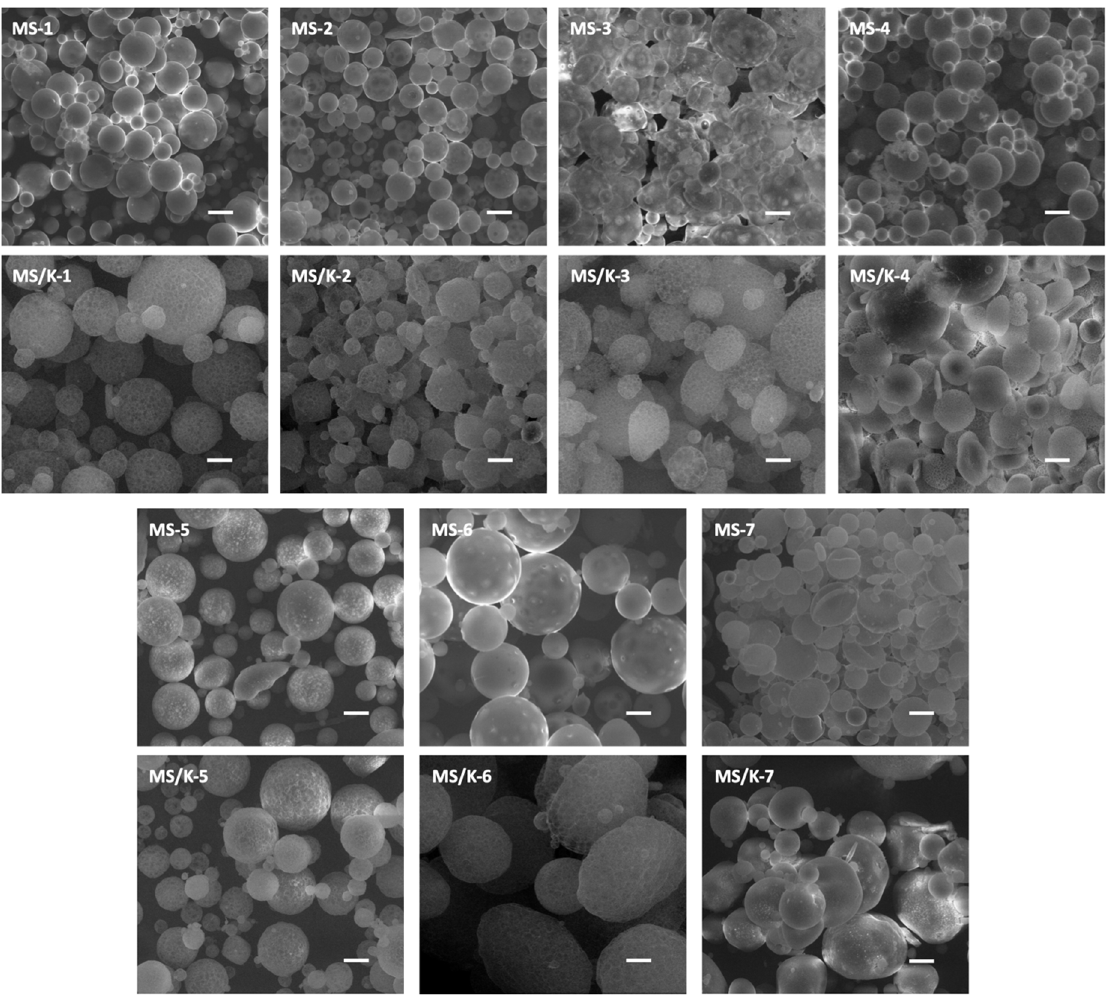
Figure 2. Representative SEM images of empty MSs and MS/Ks showing a spherical morphology. Scale bar: 20 µm. Magnification: 1000×.